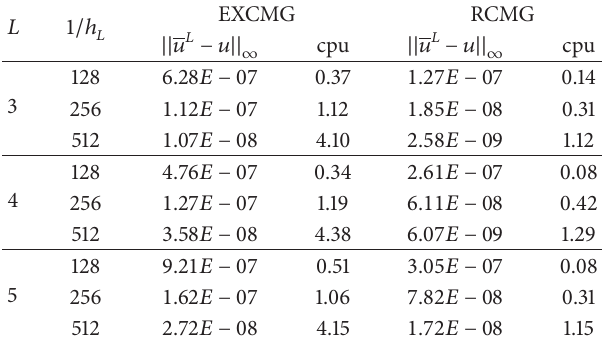
Table 1: Numerical results of EXCMG and RCMG for Example 4.